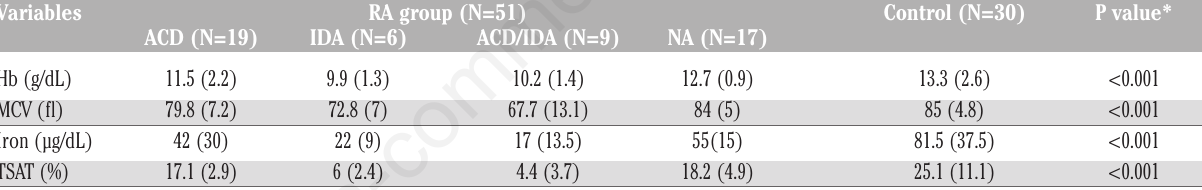
Table 1. Hematological parameters and serum iron status in RA patients and control. Variables